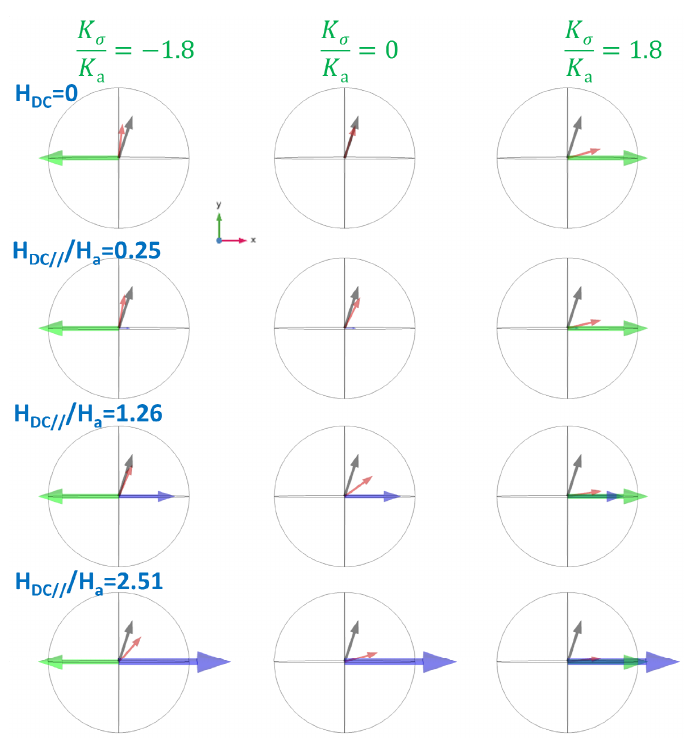
Figure A2. Snapshots of the magnetic state of the Magnetization (in red) at a given magnetic anisotropy (in black), for different stress (in green) and different longitudinal applied field (in blue).